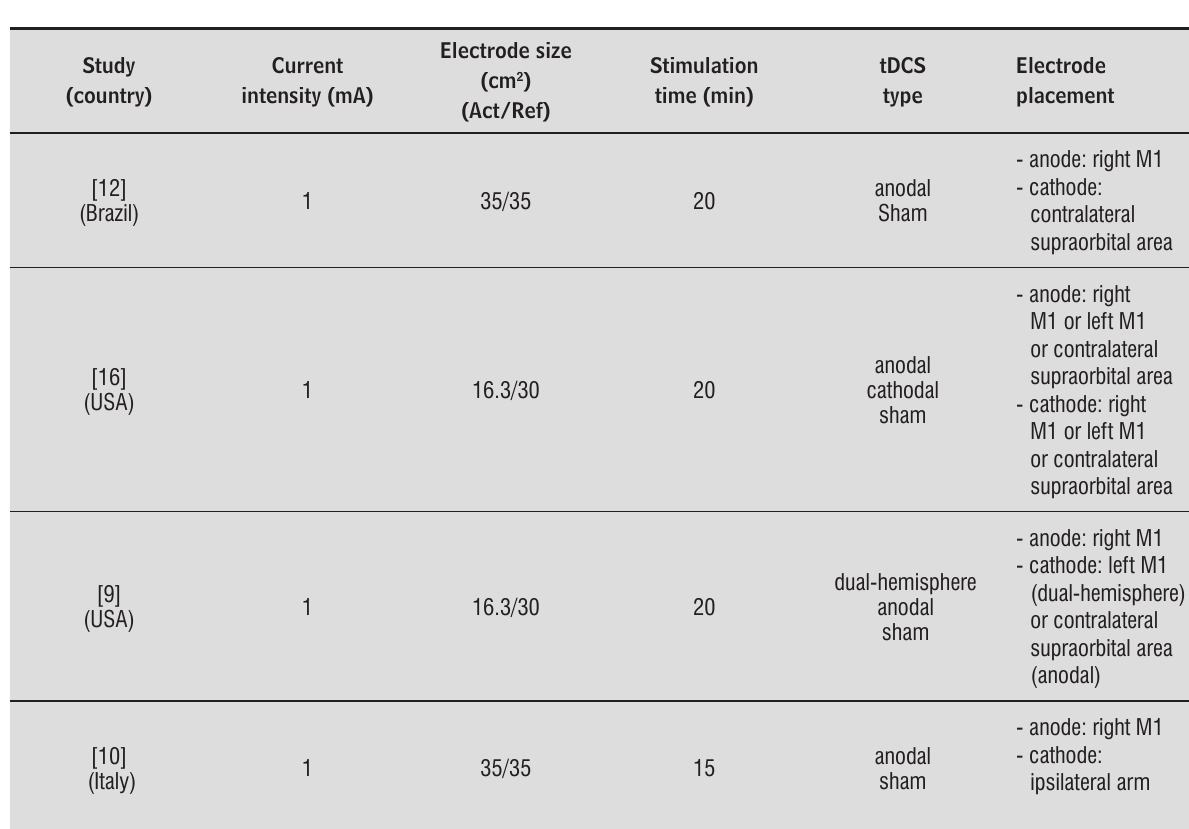
Table 2 - Parameters of tDCS protocol of the included studies